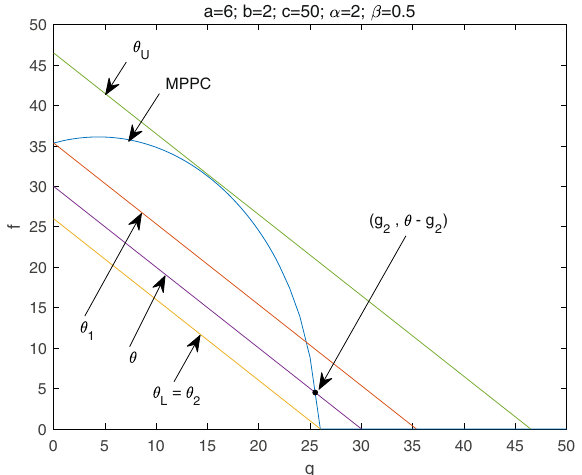
Fig. 7 The intersection ( g 2 , θ - g 2 ) when θ 1 > θ 2 .